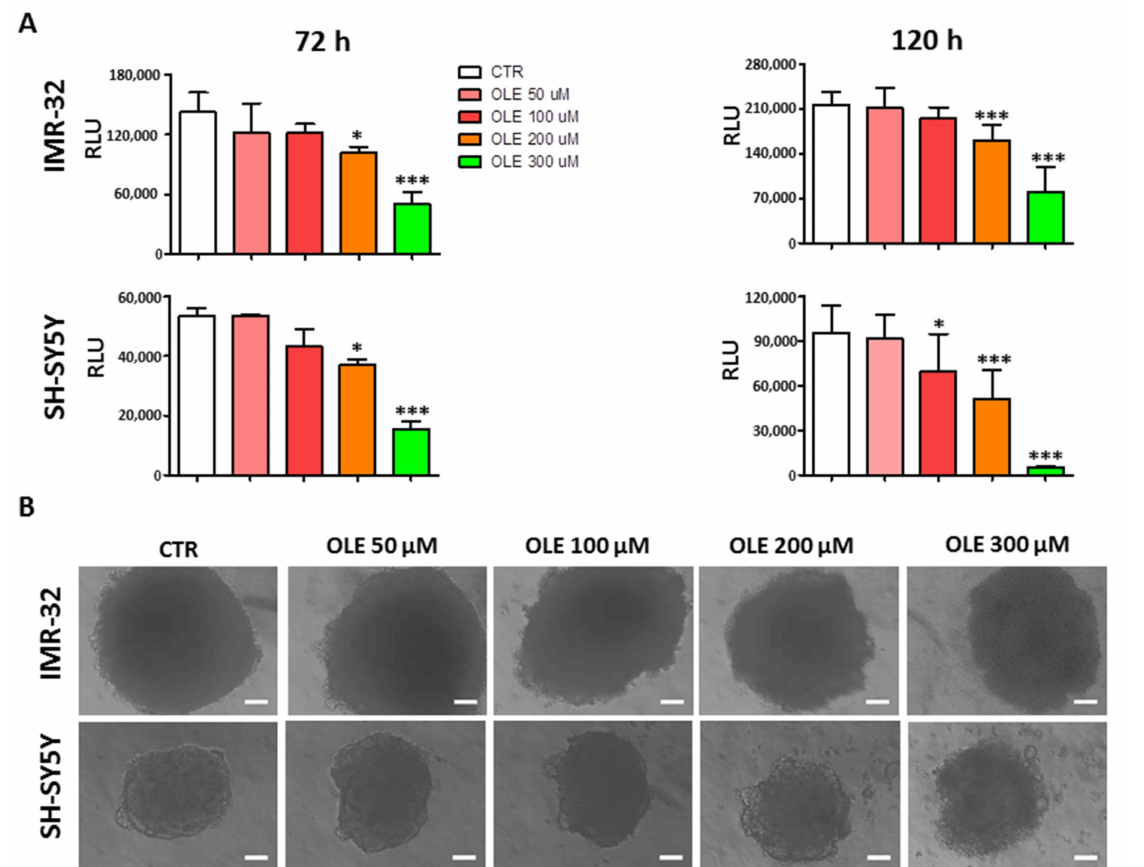
Figure 3. Dose- and time-dependent effects of OLE treatment on the viability of NB spheroids. ( A ) Cell viability determined at indicated time points, thanks to the CellTiter-Glo ® 3D Cell Viability assay. Luminescence, produced only by metabolically active cells, was recorded by TECAN Infinite 200, and recorded as relative luminescence unit (RLU). Data are expressed as mean ± SD of three independent experiments. * p < 0.05, *** p < 0.001 vs. CTR). ( B ) Representative phase-contrast microscopy images of spheroids taken at 120 h post OLE treatment. The ImageJ processing program was used. Scale bar: 100 µ m. CTR: control; OLE: olive leaf extract; uM: micromolar; h: